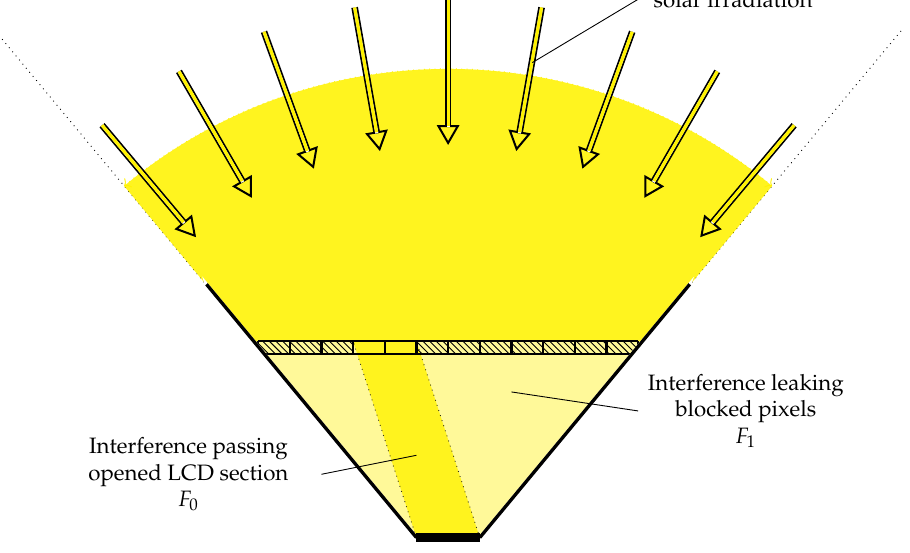
Figure 4. Reduction of solar-induced interference using the LCD filter.